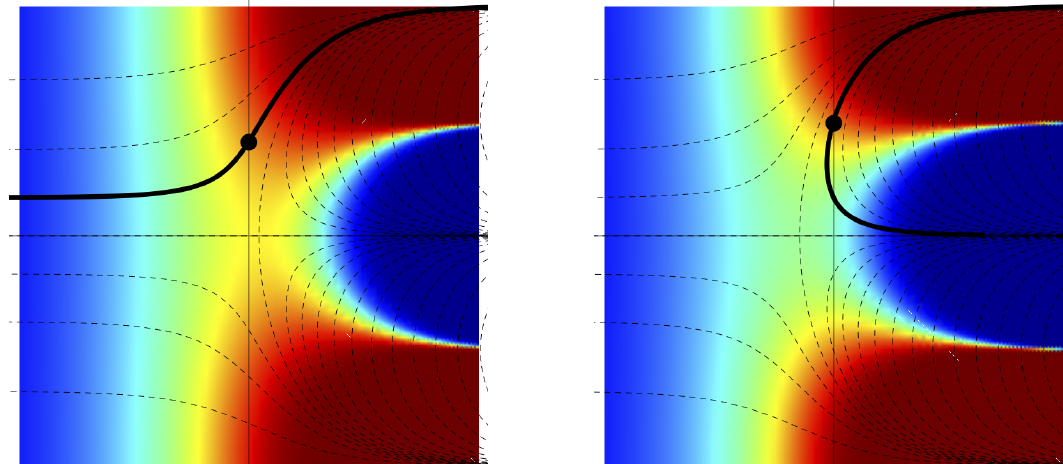
Figure 15: The steepest descent path passing through the point s = i ϕ can be of one of two types: it connects + ∞ ± i π either to −∞ + i ϕ − i λ sin ϕ (left panel), or to + ∞ (right panel). In both cases, the steepest descent contour is traced in the direction of monotonously decreasing | Im ( s ) | . However, when λ < 1 as in the left panel, no steepest descent path connects i ϕ to + ∞ . Conversely, when λ > 1 as in the right panel, there exists a steepest descent path connecting i ϕ to + ∞ provided | ϕ | is smaller than (or equal to) the critical value ϕ > 0 given by ϕ = λ sin ϕ . c c c When λ > 1 but | ϕ | > ϕ , the steepest descent path going through i ϕ escapes again c to −∞ + i ϕ − i λ sin ϕ